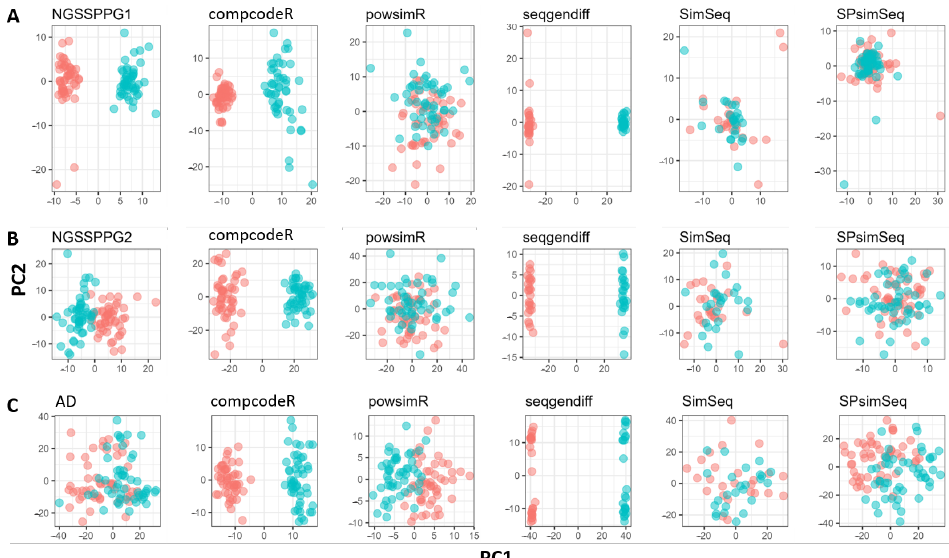
Figure 8. PCA plots for: ( A ) NGSSPPG1; ( B ) NGSSPPG2; and ( C ) AD datasets and the datasets generated with these as